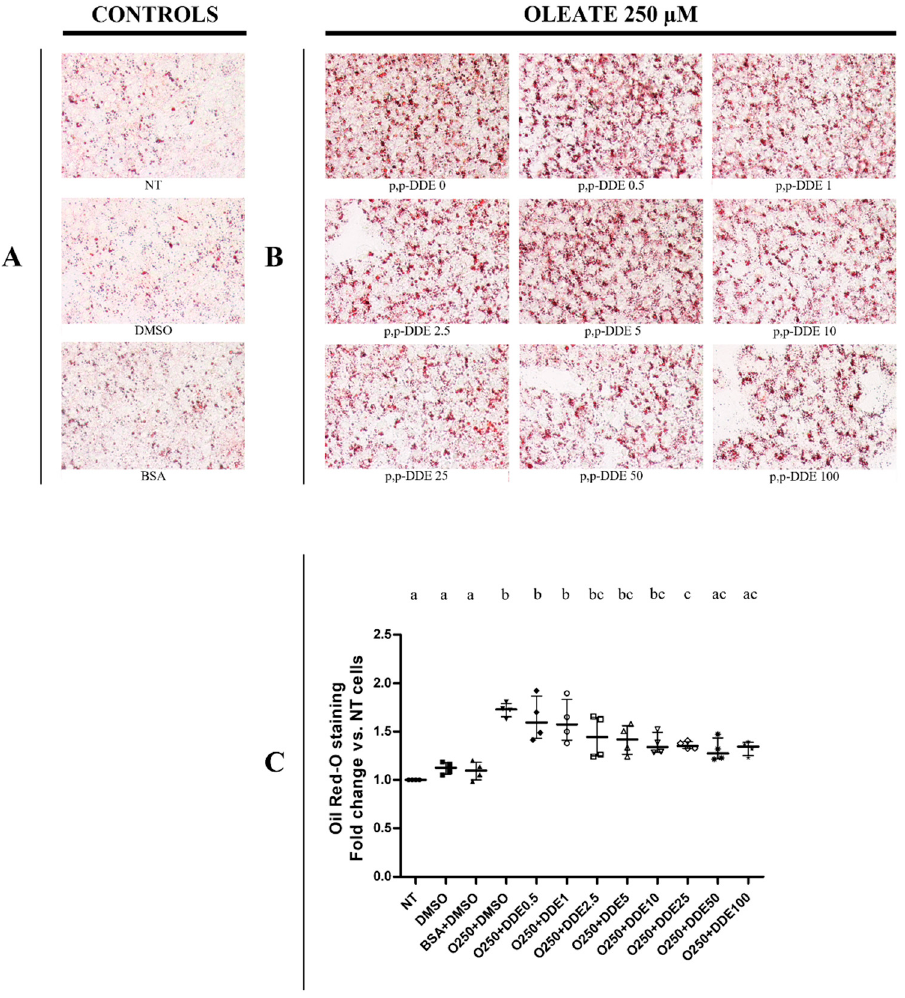
Figure 4. Total lipid content in response to different doses of DDE co-incubated with oleate. ( A ) representative images of lipid depots in control cells (NT, DMSO, BSA); ( B ) representative images of cells treated with oleate or with oleate and increasing DDE doses. Original image magnification used: 40×. Quantitative analyses were obtained quantifying oil Red-O accumulation in cells. Oil-Red O quantifications were measured spectrophotometrically (490 nm). Data graphically represented as median with interquartile of range for 4 biological replicates ( C ). Three different control groups of cells were tested (non-treated cells, NT; DMSO and BSA) to evaluate the specific effect of DDE on fatty acid deposition. Statistical analyses were performed by using GraphPad Prism software. One-way ANOVA analysis was followed by Bonferroni’s post-hoc test: different letters indicate statistically different values.